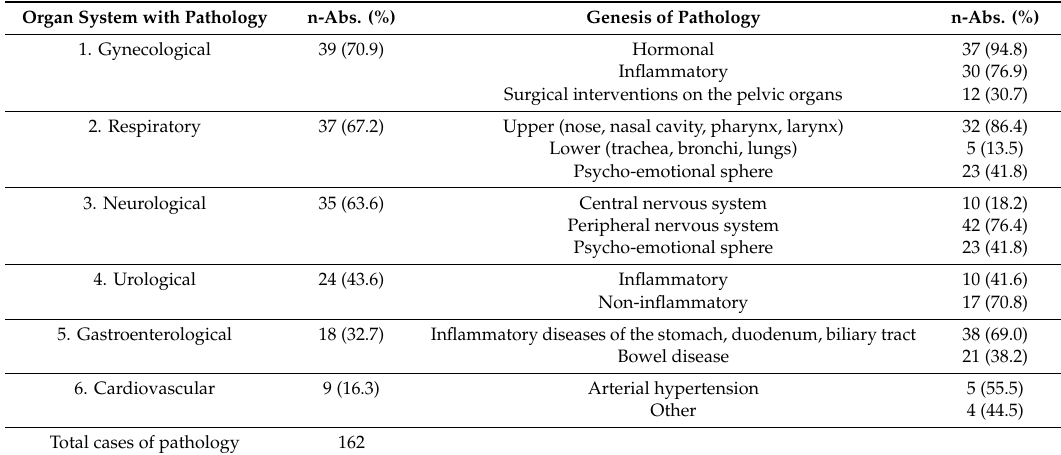
Table 3. Concomitant pathology and the source of its occurrence in the group of patients with urethral pain syndrome (UPS) ( n =